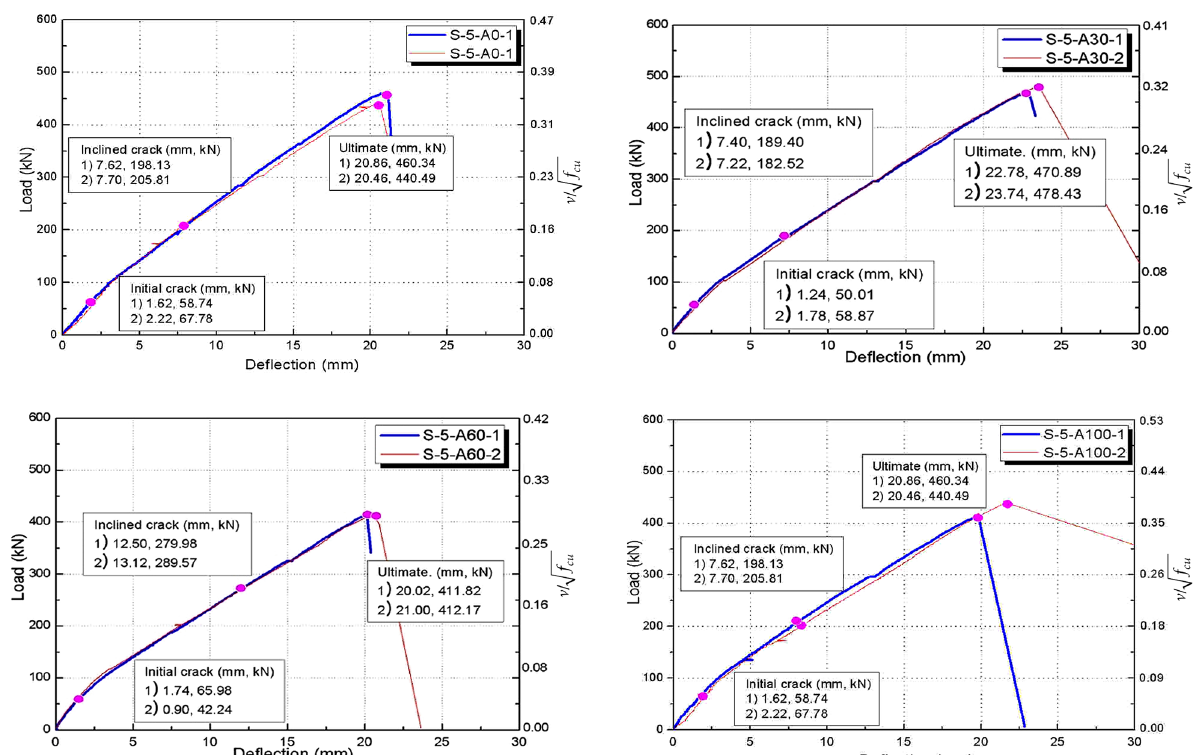
(b) Load displacement curve with recycled aggregate replacement Fig. 3. Load displacement curves